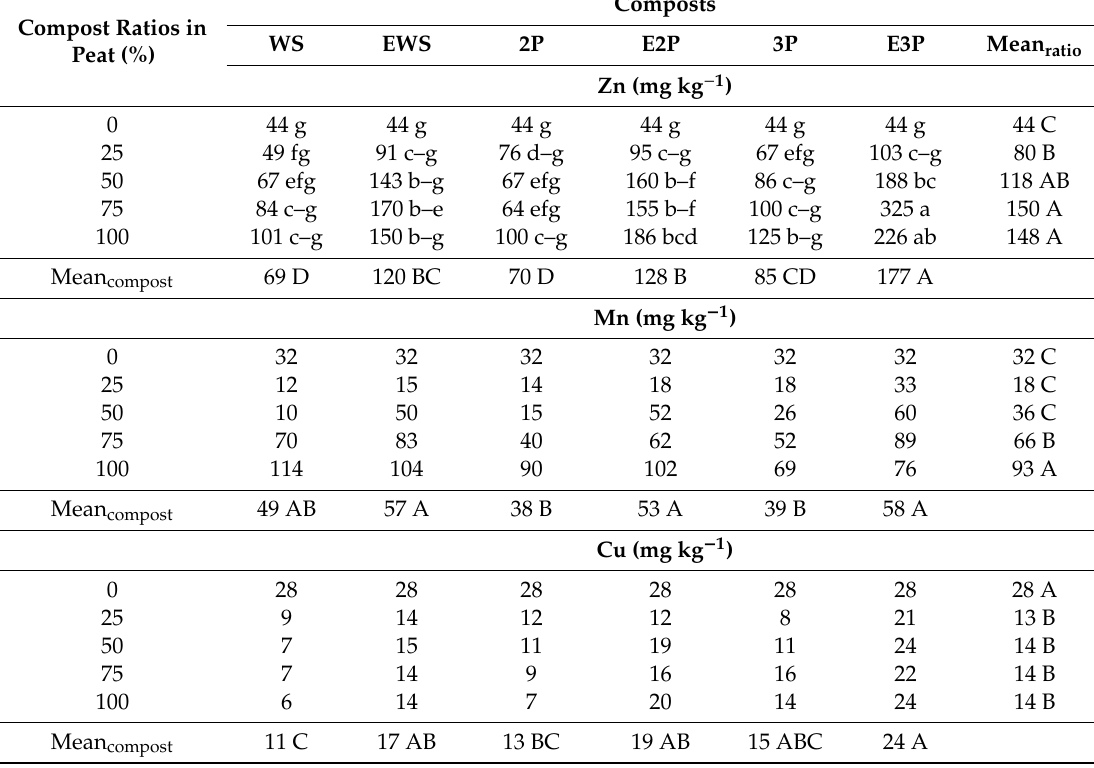
Table 10. E ff ects of the treatments on micro element concentrations of